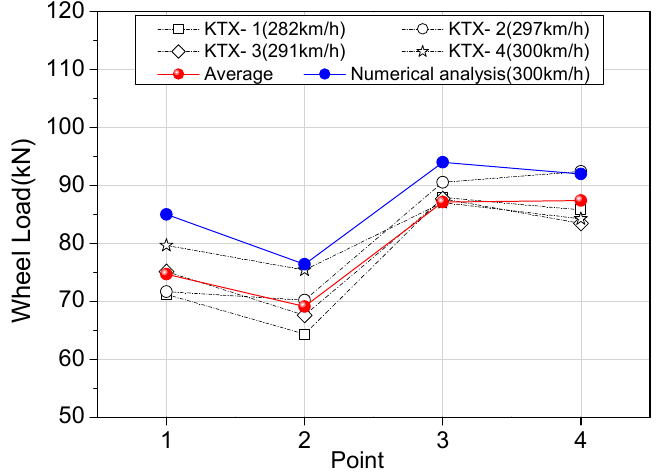
Figure 17. Comparison of wheel load variation by section in the measurement and analysis.